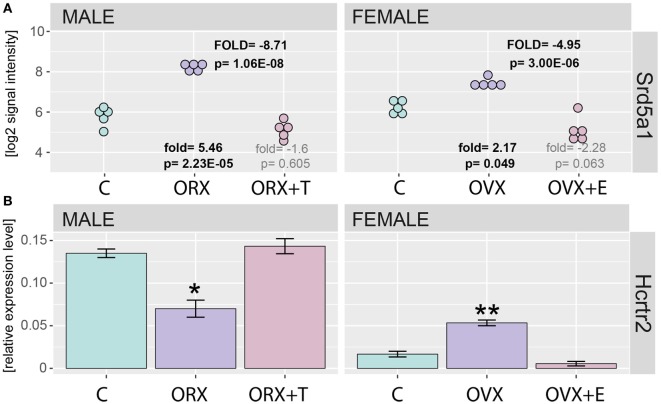
Expression of Srd5a1 and Hcrtr2 genes in applied experimental model. (A) Expression values were extracted from microarray normalized data set and presented as log2 signal intensity scale. Fold and p values were calculated in relation to appropriate control groups (showed on bottom) or between gonadectomized [orchiectomy (ORX) or ovariectomy (OVX)] and gonadectomized + sex hormone replaced (ORX + T, OVX + E) groups (showed on the top “FOLD” in capitals). In each group, n = 5. p Value obtained from moderated t test with FDR correction (incorporated in the Limma package of the software). (B) QPCR assay of Hcrtr2 genes in adrenals of adult male and female control, gonadectomized and gonadal hormone replaced rats. Bars represent means ± SEM (n = 5). HPRT gene was used as reference for data normalization. Statistically significant differences in relation to control group (Student’s t-test): *p < 0.05; **p < 0.02; ***p < 0.01; ****p < 0.001.